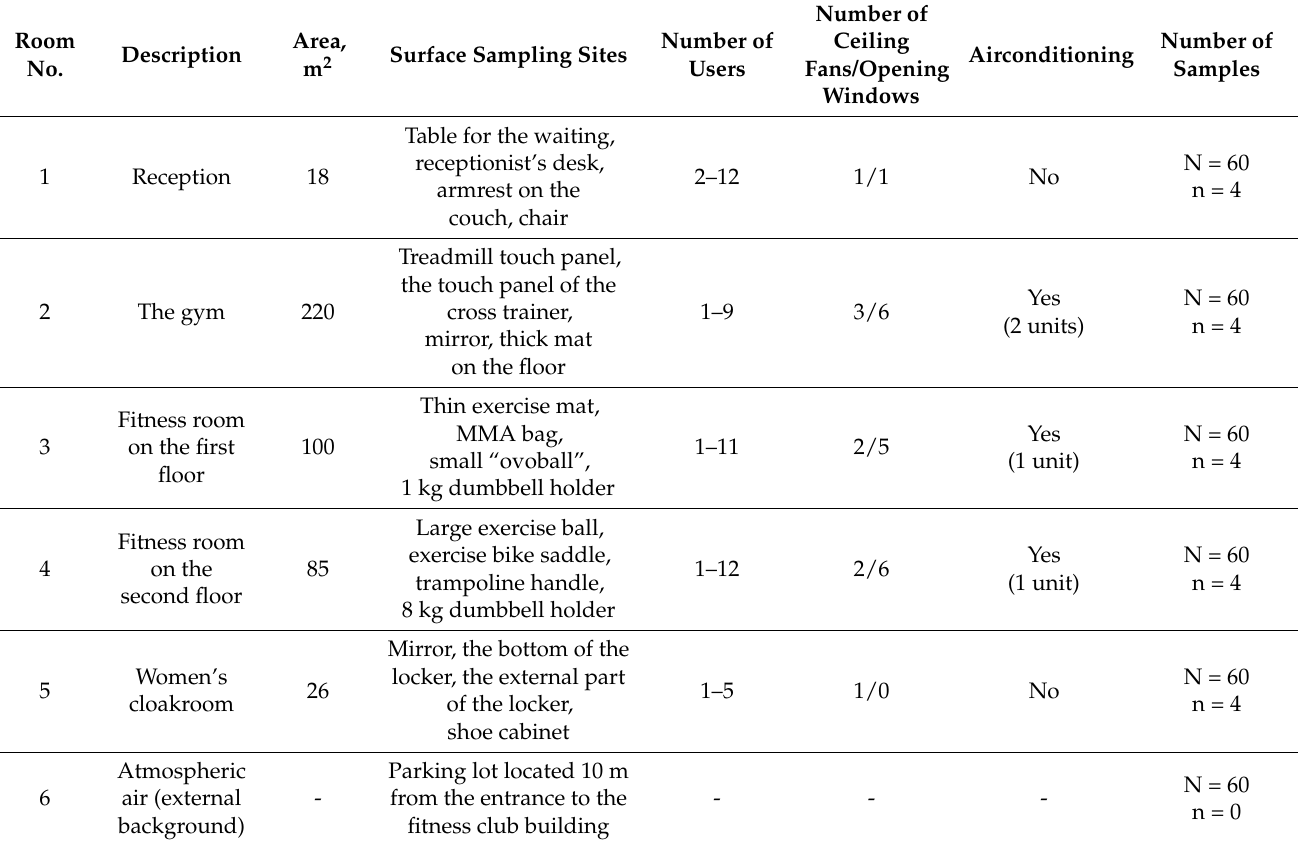
Table 3. Characteristics of the sampling sites at points in the tested fitness